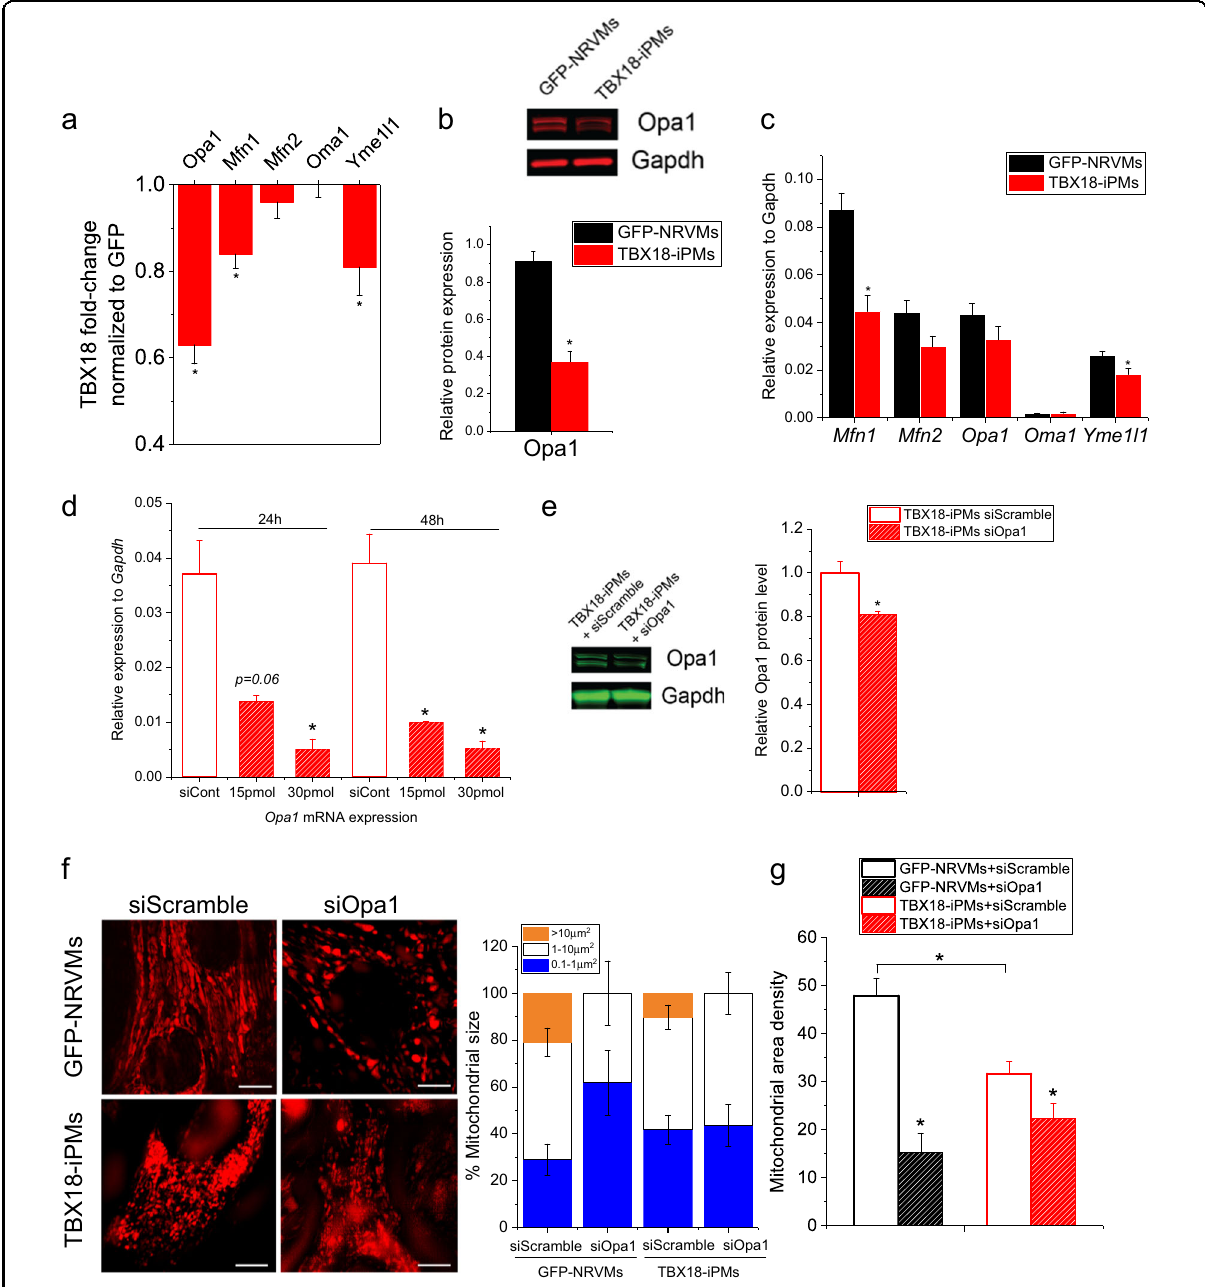
Fig. 4 The reduced level of Opa1 in TBX18-iPMs correlates with smaller mitochondria. a Proteomic quanti fi cation of mitochondrial fusion factors, Mfn1, Mfn2, Opa1, Oma1, and Yme1l1 in the TBX18-iPM proteome ( n = 3). b Validation of Opa1 protein expression levels in D3 GFP-NRVMs and TBX18-iPMs ( n = 6). c Relative mRNA expression levels of fusion-related factors, including Mfn1 , Mfn2 , Opa1 , Oma1 , and Yme1l , normalized to Gapdh in GFP-NRVMs and TBX18-iPMs ( n = 6). d mRNA level of Opa1 after siOpa1 transfection in TBX18-iPMs ( n = 4). e Reduced protein level of Opa1 with siOpa1 transfection in TBX18-iPMs. Representative immunoblot (left) and quantitative graph (right) ( n = 4). f Mitochondrial size distribution of GFP-NRVMs and TBX18-iPMs with siScramble or siOpa1 transfection. Representative pictures of Mitotracker staining (left) and % mitochondrial size distribution divided as >10 μ m 2 , 1 – 10 μ m 2 , and 0.1 – 1 μ m 2 (right) ( n = 4 for GFP-NRVMs transfected with siScramble or siOpa1 and n = 6 for TBX18- iPMs transfected with siScramble or siOpa1). g Mitochondrial density in given cytoplasmic area of GFP-NRVMs and TBX18-iPMs with siScramble or siOpa1 transfection ( n = 4 for GFP-NRVMs transfected with siScramble or siOpa1 and n = 6 for TBX18-iPMs transfected with siScramble or siOpa1). * p <